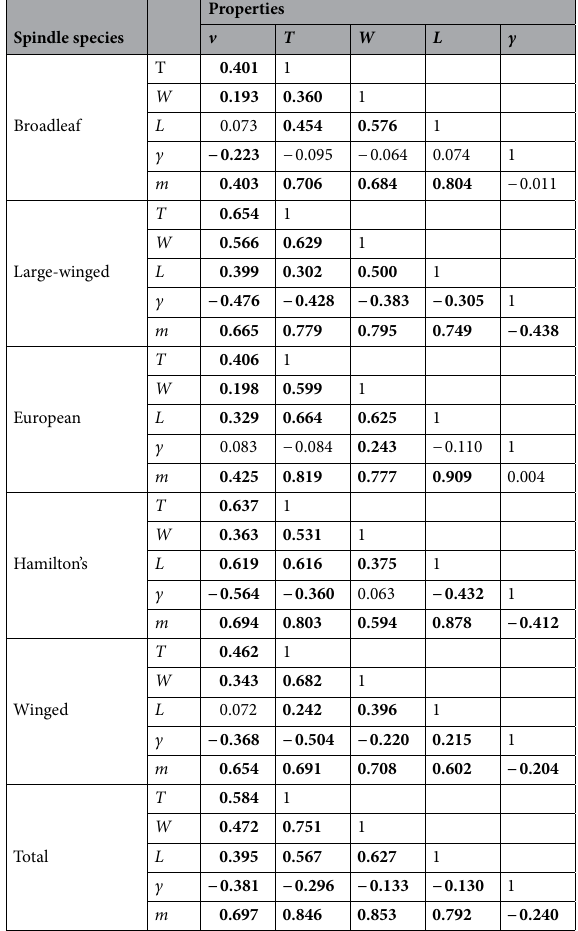
Table 2. Coefficients of linear correlation between the basic physical properties of spindle seeds. v terminal velocity, T thickness, W width, L length, γ angle of external friction, m mass. Values in bold indicate statistically significant